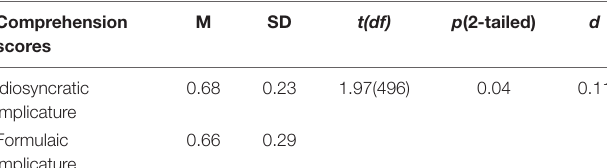
TABLE 2 | Paired-sample t -test between the two types of implicatures ( n =